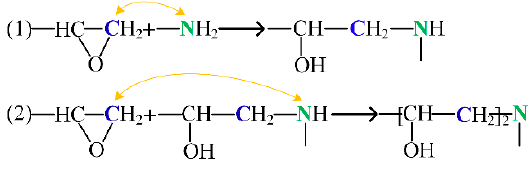
Figure 3. Cross-linking reaction principle.